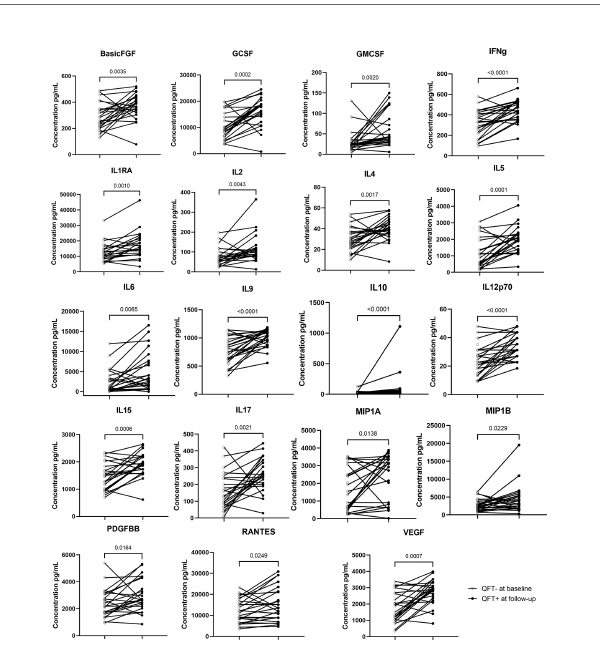
FIGURE 3 | Wilcoxon matched paired test was applied. Symbols and lines graph depicting individual changes in cytokines/chemokines concentrations (pg ml − 1 ) from recent QFT converters in baseline samples (n = 27) to recent QFT converters in the follow-up sample (n = 24).